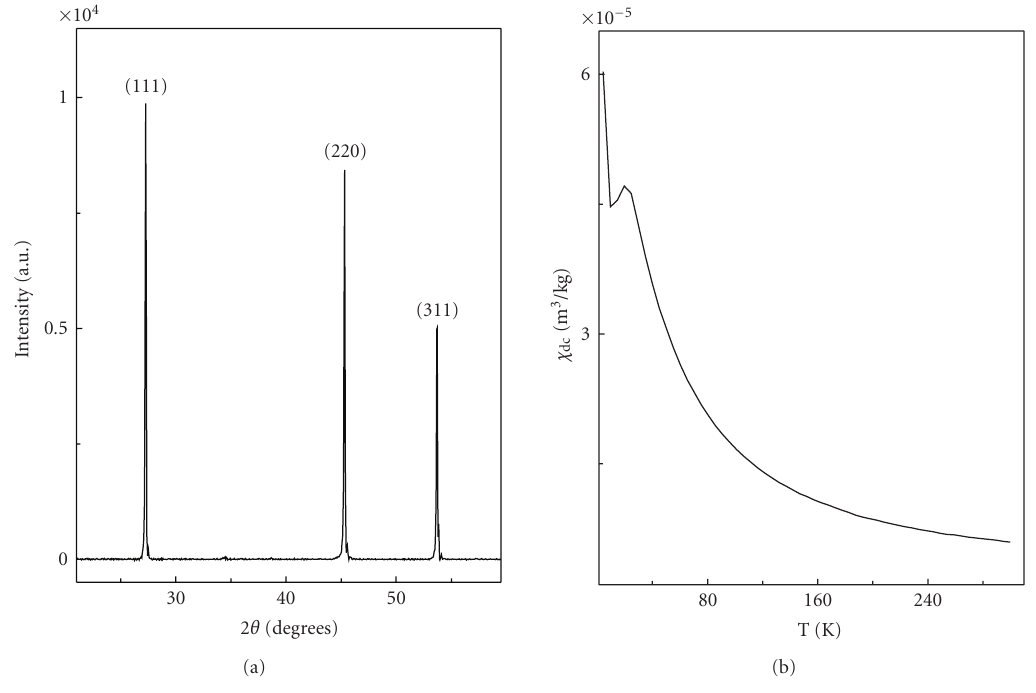
Figure 3: (a) XRD pattern of NW material. (b) TRM